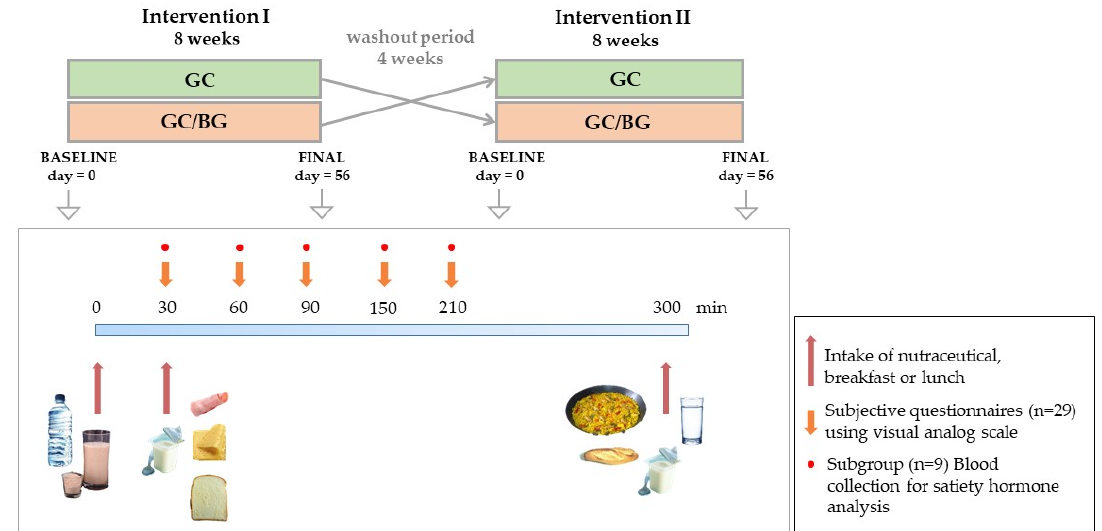
Figure 1. Study design and interventions carried out at each study visit. Table 1. Macronutrient composition (g) and energy value (Kcal) of breakfast and